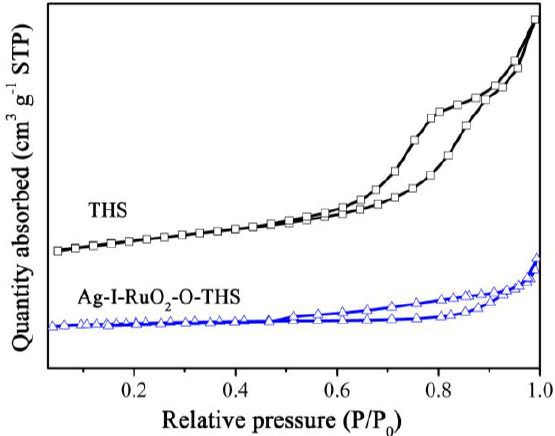
Figure 2. N 2 adsorption-desorption isotherms of THS and Ag-I-RuO 2 -O-THS.